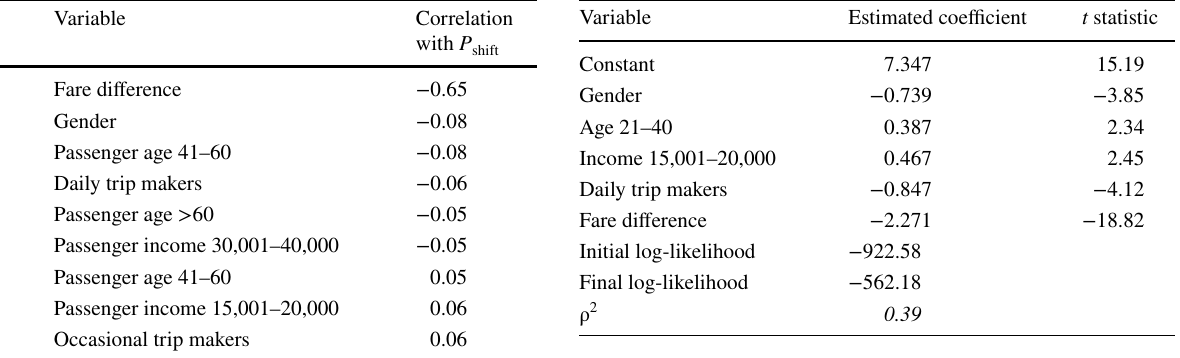
Table 4 Selected variables for model development